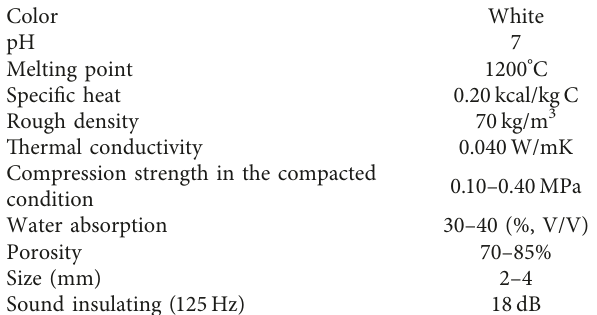
Table 1: Properties of expanded perlite